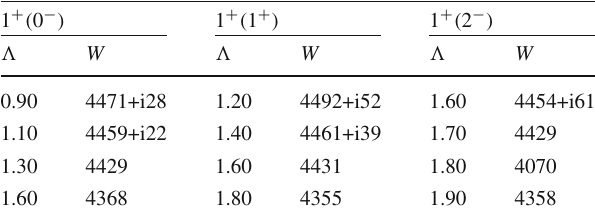
Table 2 The bound states from the D ∗ ¯ D 1 interaction with typical cut- offs (cid:16) . The cutoff (cid:16) and energy W are in units of GeV, and MeV,